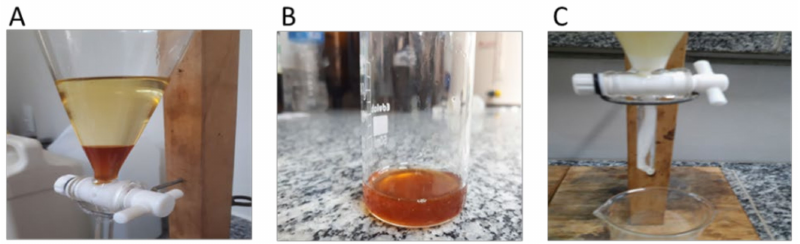
Figure 1. Chemical procedures for processing oil samples. ( A ) Decantation. ( B ) Glycerol. ( C ) Biodiesel wash.